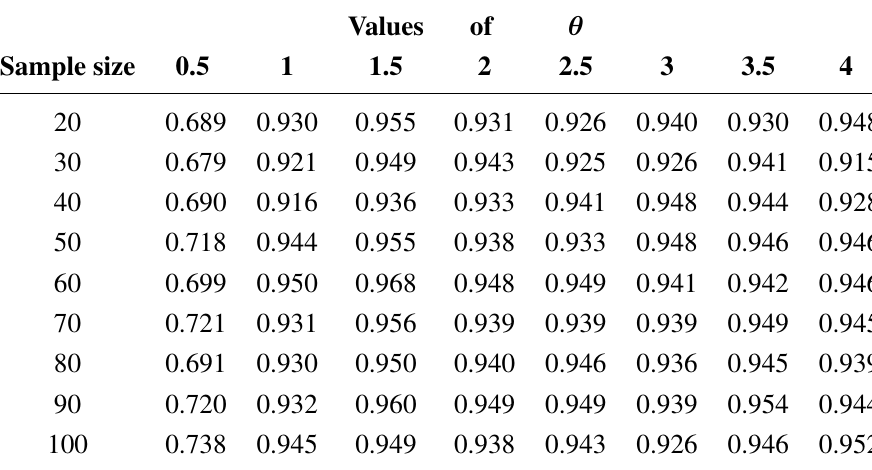
Table 1. Estimated coverage probability of the 95% confidence intervals for the mean parameter, µ , using the observed information